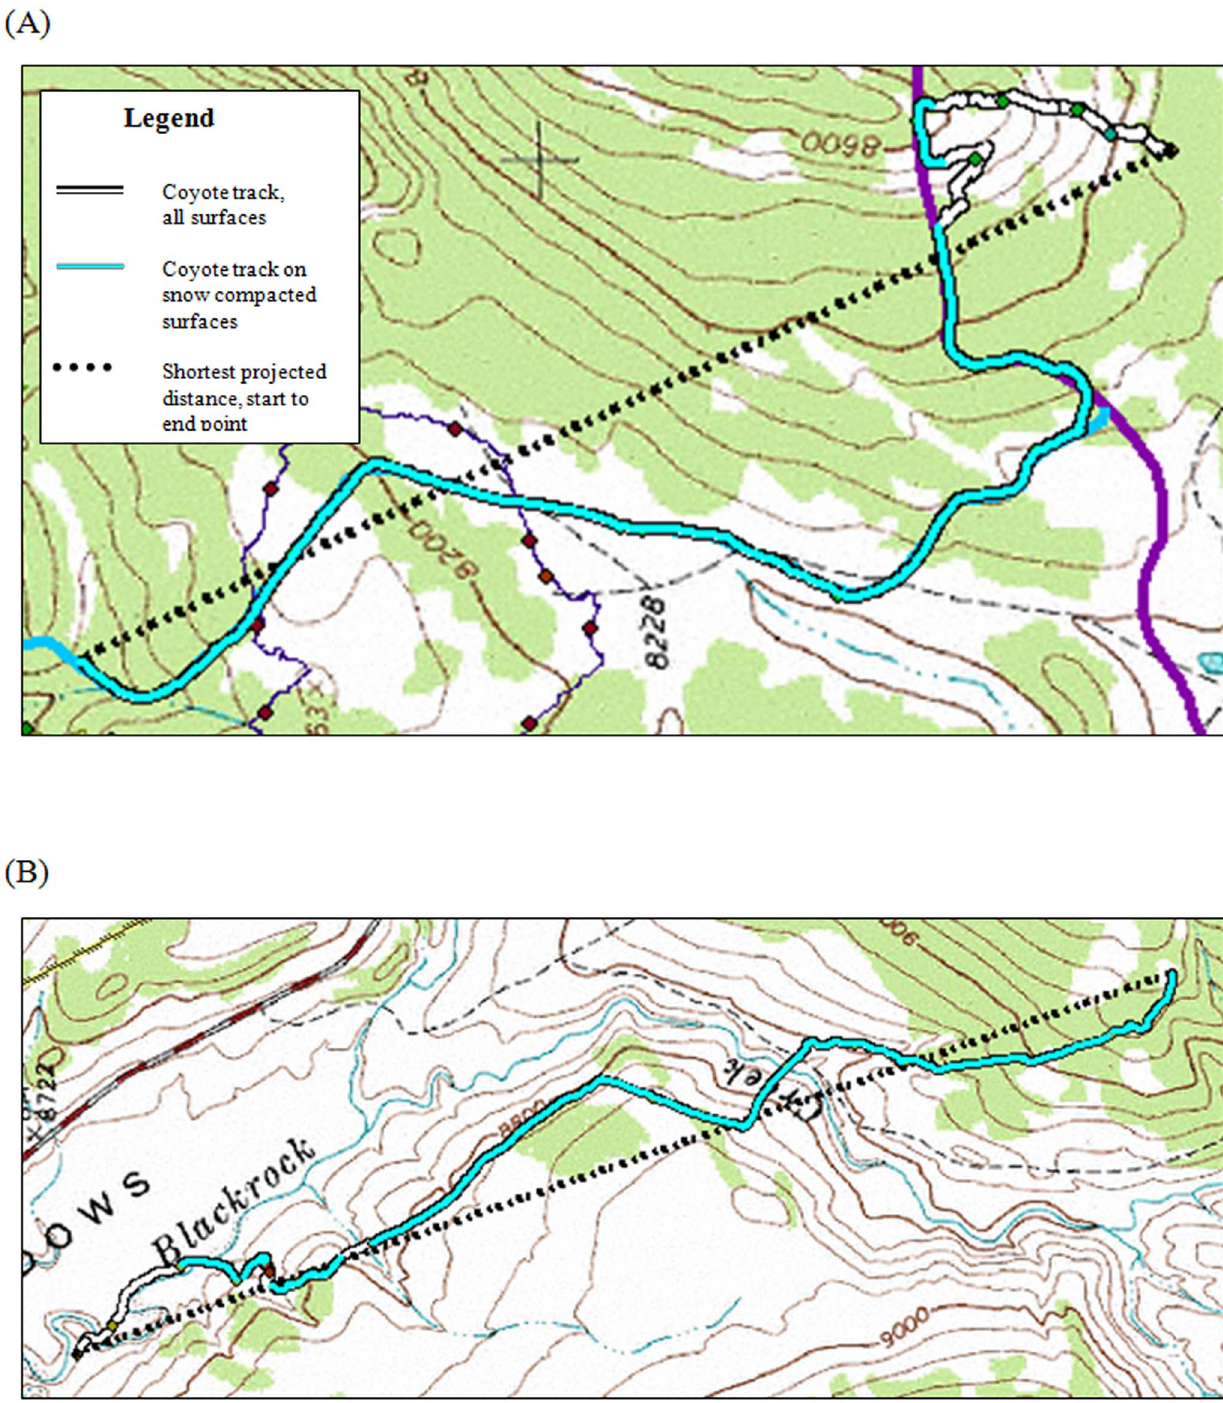
Figure 3. Examples of coyote travel paths in the presence of snowmobile trails: (A) Male coyote 05 on 4 January2008, and (B) Male coyote 15 on 3 April 2008, northwestern Wyoming,